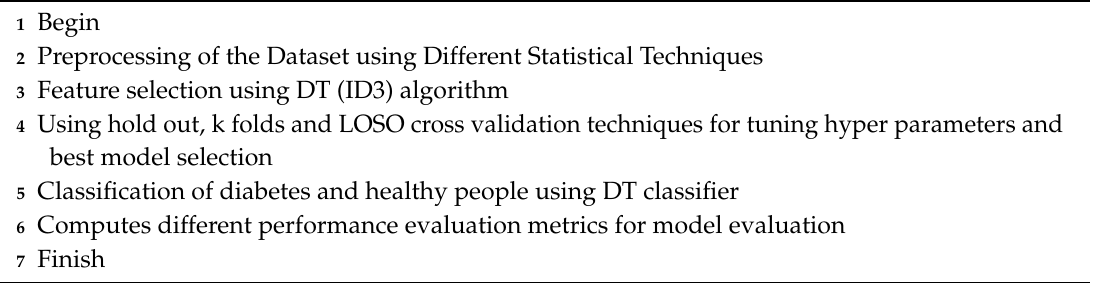
Algorithm 5: Proposed method for Diabetes